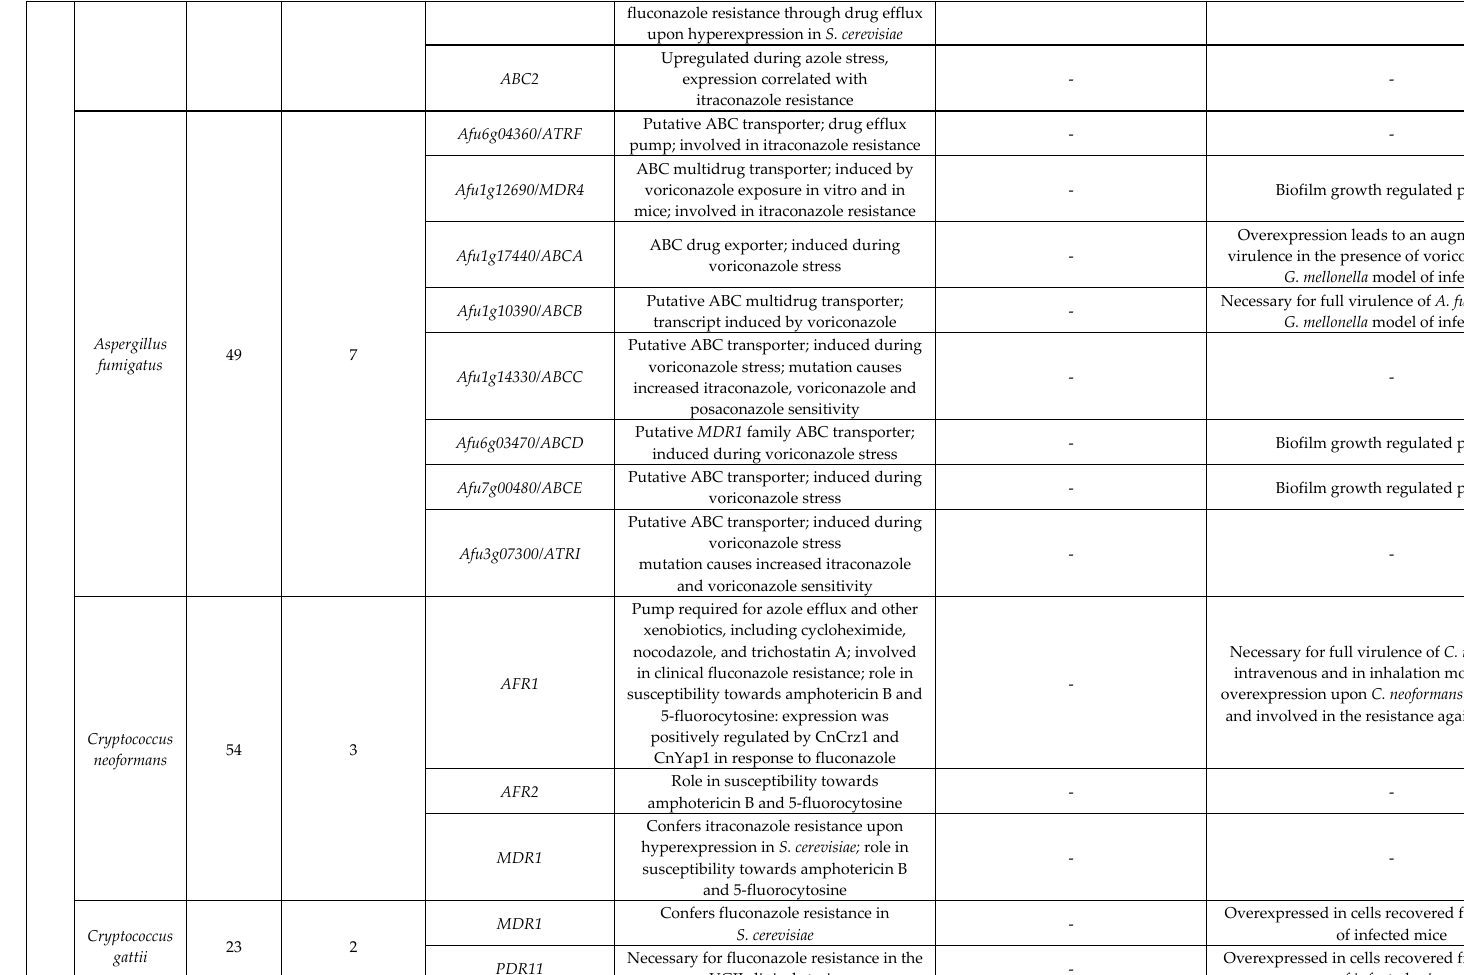
Genes 2018 , 9 , x FOR PEER